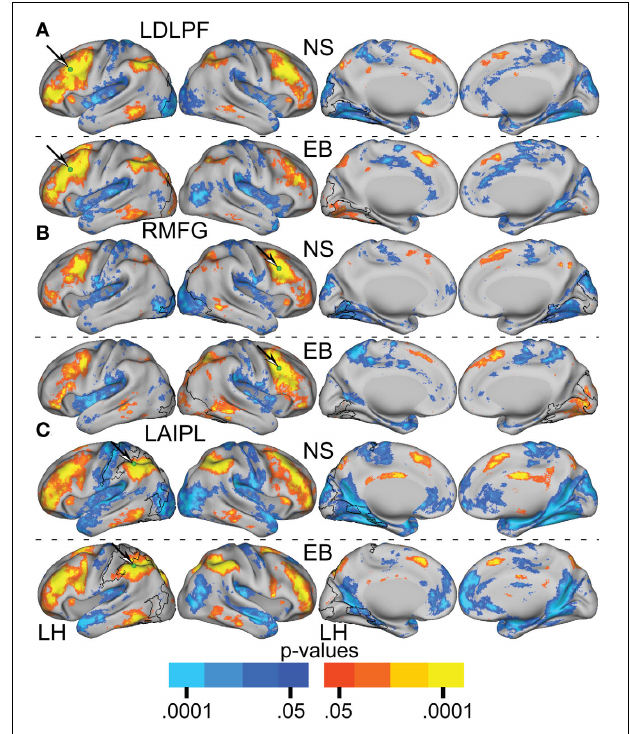
FIGURE 6 | Resting-state functional connectivity random effect Z ( r ) maps in normally sighted (NS) and early blind (EB) associated with selected seed regions (A–C) identified in Table 2. A green sphere marks the location of the seed region in each map. See text for Figure 4 .